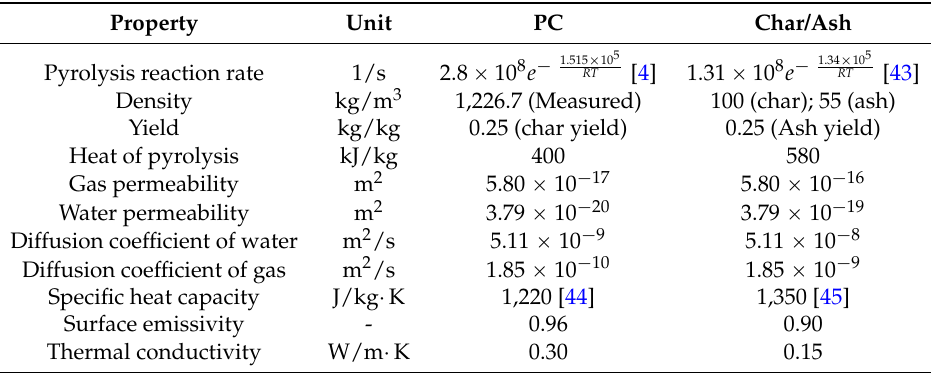
Table 3. The thermal properties of PC considered as the input for modeling.